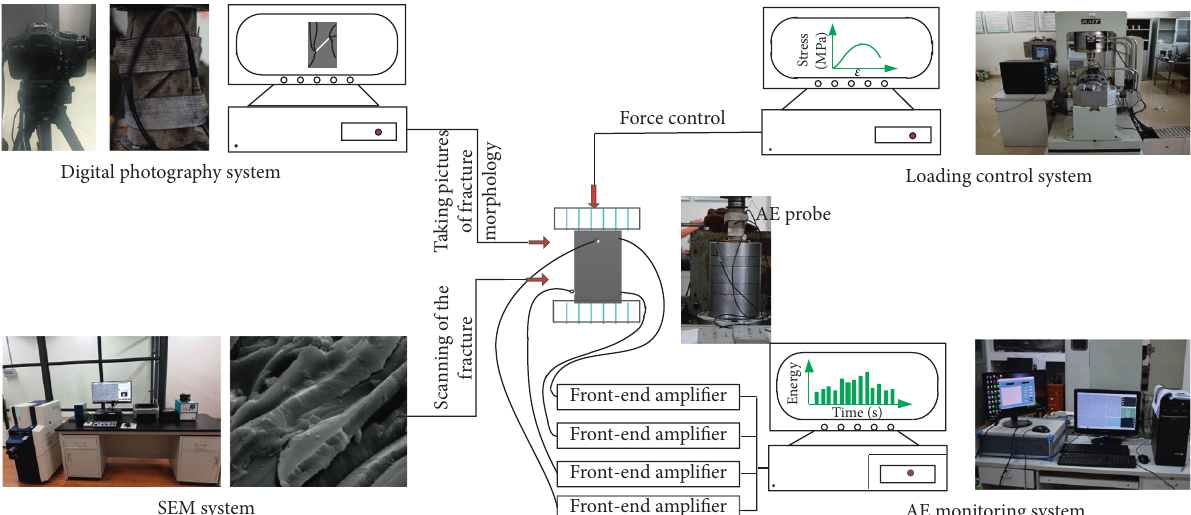
Figure 2: Loading and monitoring